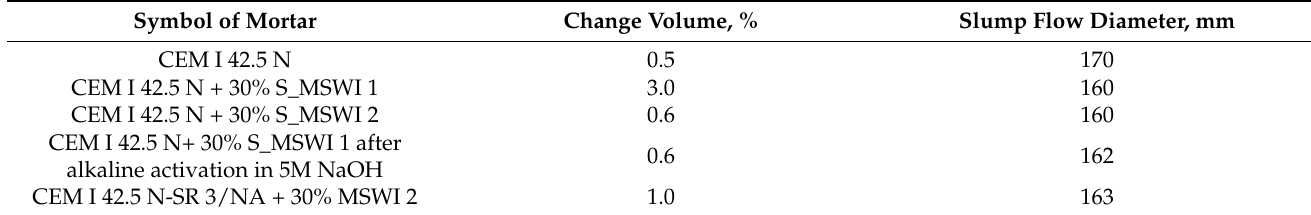
Table 8. The test results of the change of the volume and consistency of the mortars.